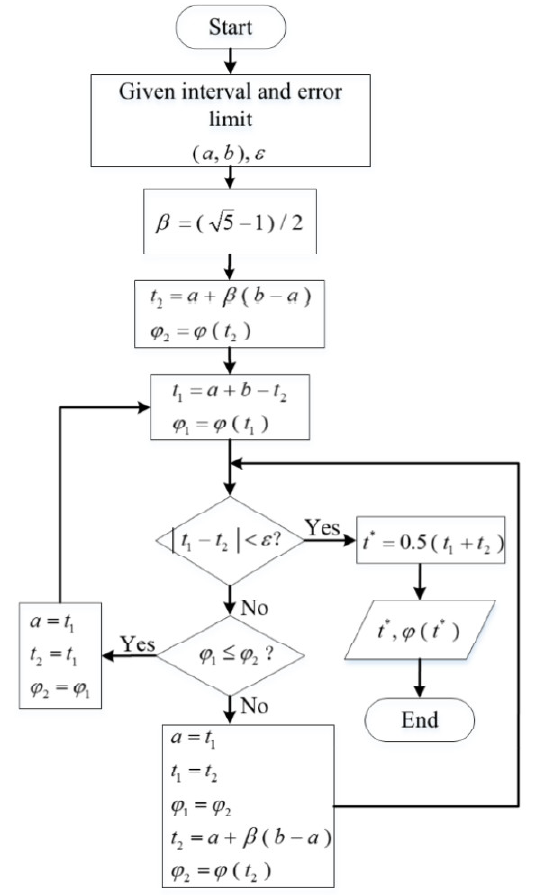
Figure 12. The flow chart of the golden section algorithm.